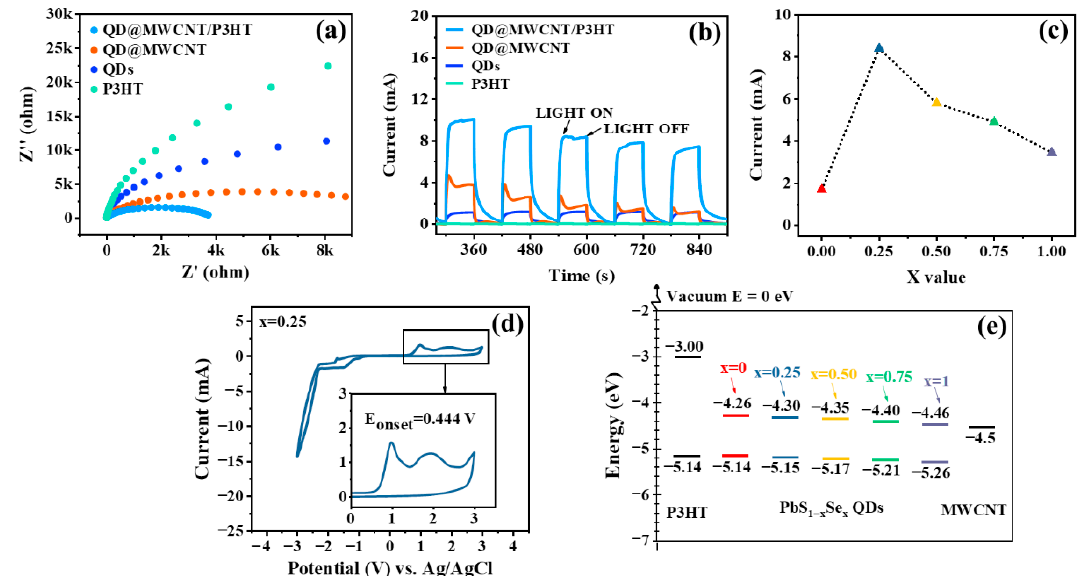
Figure 4. ( a ) EIS and ( b ) I-t curves of P3HT, PbS 0.75 Se 0.25 QDs, PbS 0.75 Se 0.25 -QD@MWCNT and PbS 0.75 Se 0.25 - QD@MWCNT/P3HT. ( c ) Photocurrent as a function of x value in PbS 1 − x Se x -QD@MWCNT/P3HT. ( d ) CV plot of PbS 0.75 Se 0.25 QDs. ( e ) Energy level diagram of the P3HT and PbS 1 − x Se x QDs. The work function of MWCNTs was referred to in the previous report